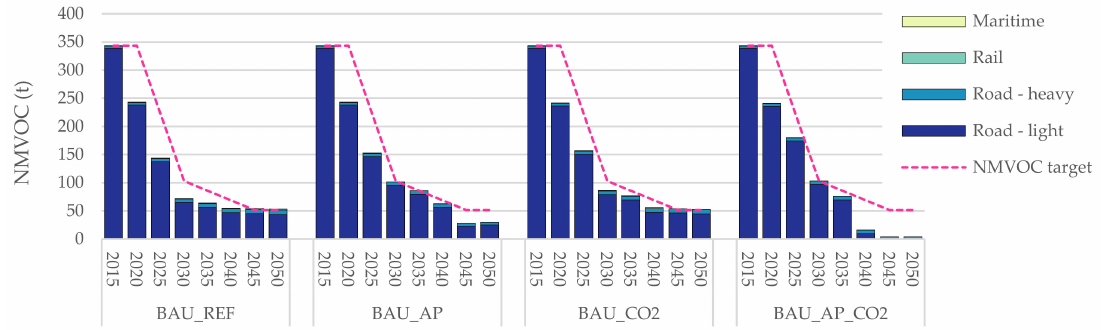
Figure A2. By-mode tailpipe emissions of non-methane volatile organic compounds (NMVOCs) in the Business-as-usual scenarios (t). Note : Road—heavy = buses, MGVs and HGVs; Road—light = cars and